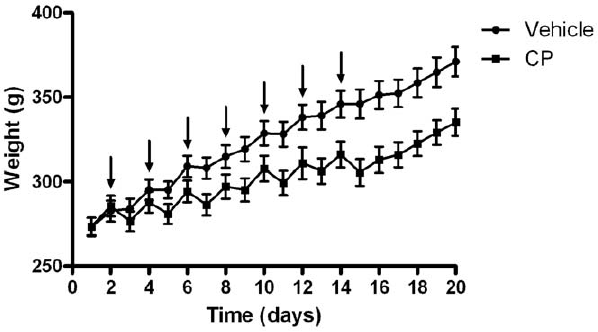
Figure 1. Body weights. Body weights of rats (mean 6 SEM) throughout the study. Arrows indicate CP (30mg/kg)/saline